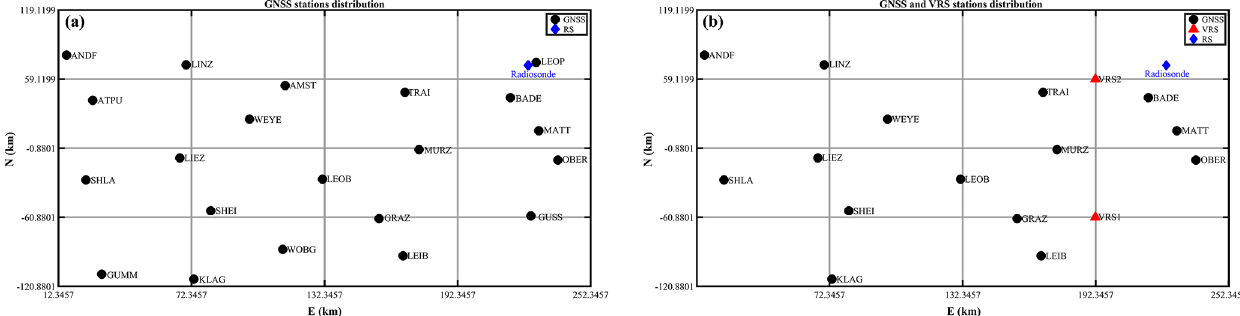
Figure 5. GNSS stations distribution in Scheme 1 (a) and GNSS and VRS distribution in Scheme 2 (b) , where GNSS stations, VRS stations and Radiosonde station are displayed in black, red and blue colors, respectively.